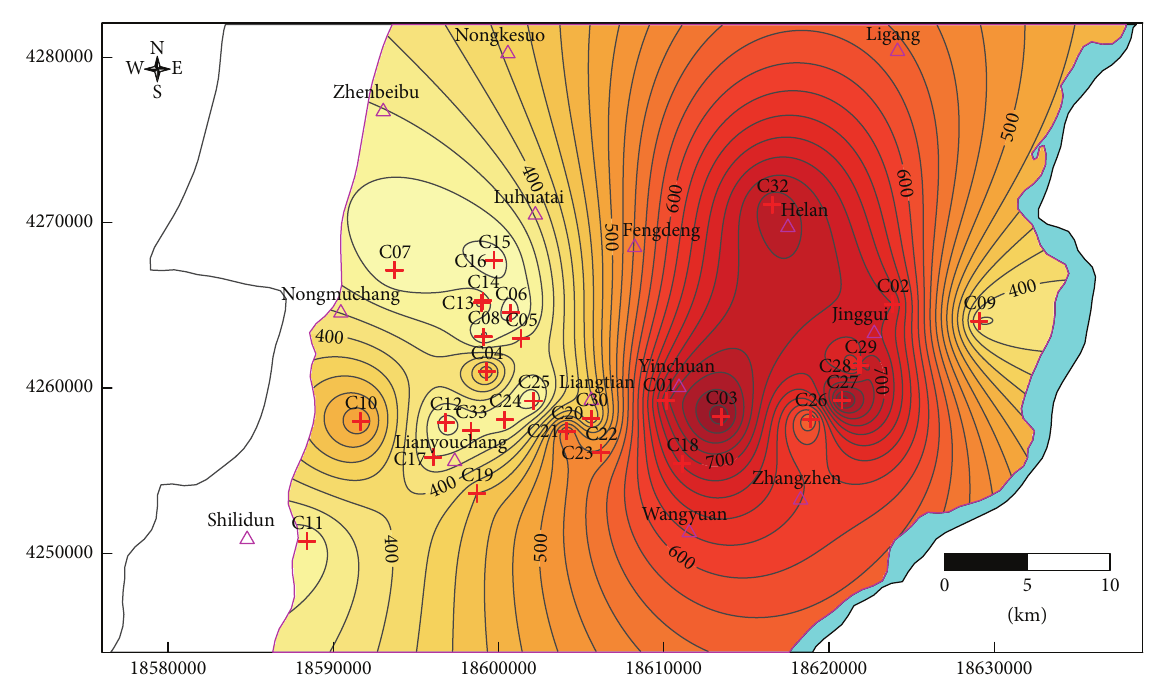
∗∗ Correlation = significant at the level 0.01 (2-tailed). ∗ Correlation = significant at the level 0.05 (2-tailed).